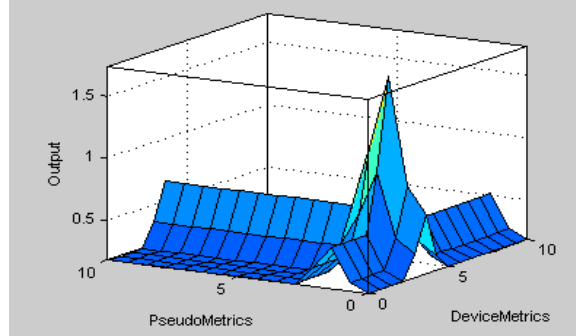
metrics input and the corresponding output